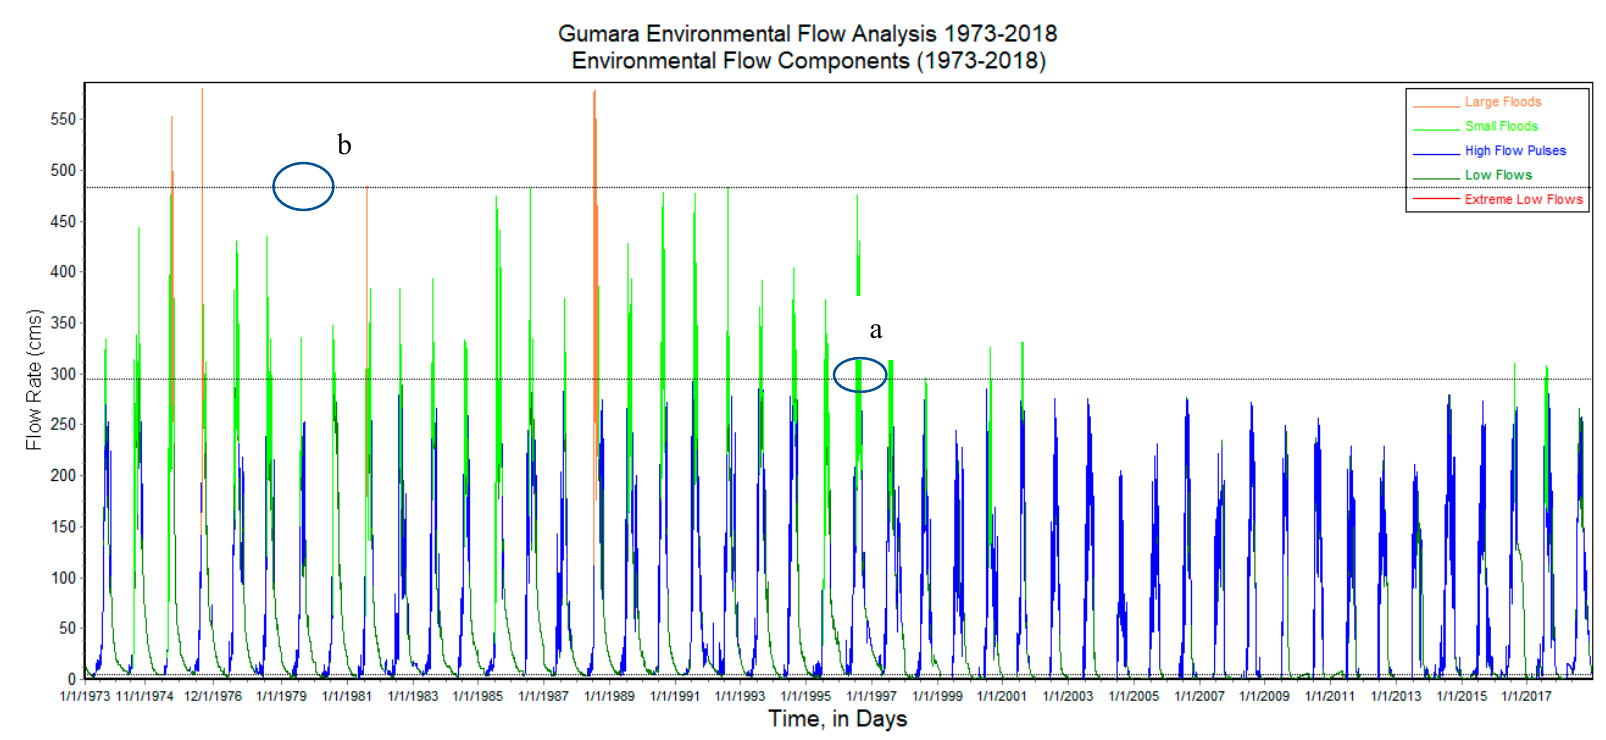
Figure 11. Environmental Flow Components of Gumara River; Extreme Low Flow, Low Flow, High Flow Pulse, Small Floods and Large Floods. The horizontal line ( a ) shows the small flood minimum peak flow and the horizontal line ( b ) shows large flood minimum peak flow.